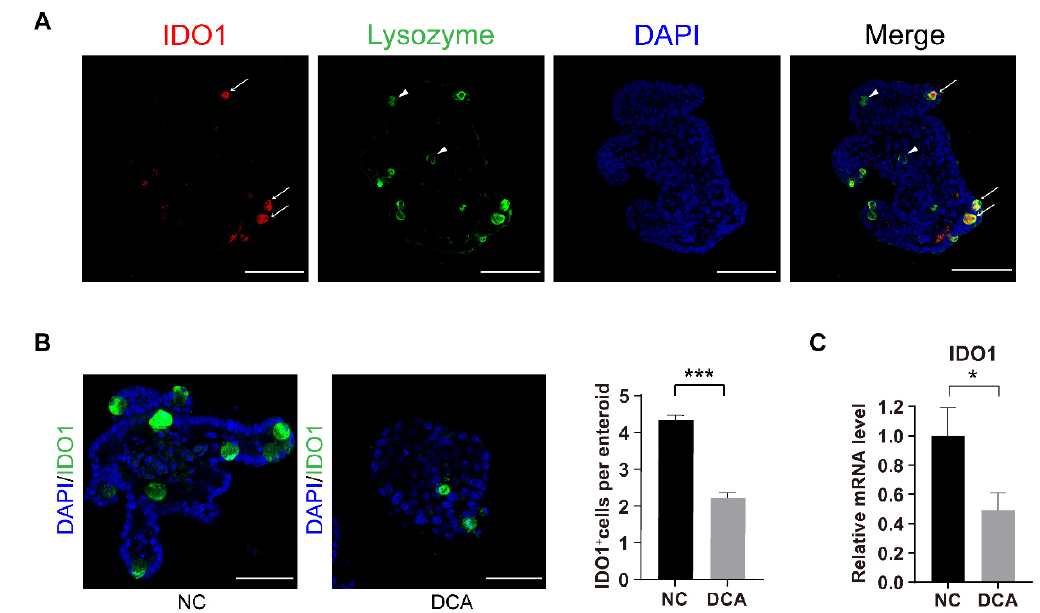
Figure 7. DCA downregulates IDO1 in vitro. ( A ) Immunofluorescence staining of DAPI (blue), IDO1 (red) and lysozyme (green) in enteroids. White arrow, IDO1 + PCs; white triangles, IDO1 − PCs; scale bars, 100 µ m. ( B ) Representative immunofluorescence images of IDO1 in enteroids cultured with DMSO or 100 µ M DCA for 48 h and relative analysis of IDO1 + cells per enteroid (n = 3); scale bars, 25 µ m. ( C ) Relative mRNA levels of IDO1 in isolated crypts cultured in vitro (n = 7) in different groups. Data are shown as the mean ± SEM. IDO1, indoleamine 2,3-dioxygenase 1; PCs, Paneth cells; NC, negative control; DCA, deoxycholic acid. * p < 0.05; *** p < 0.001.